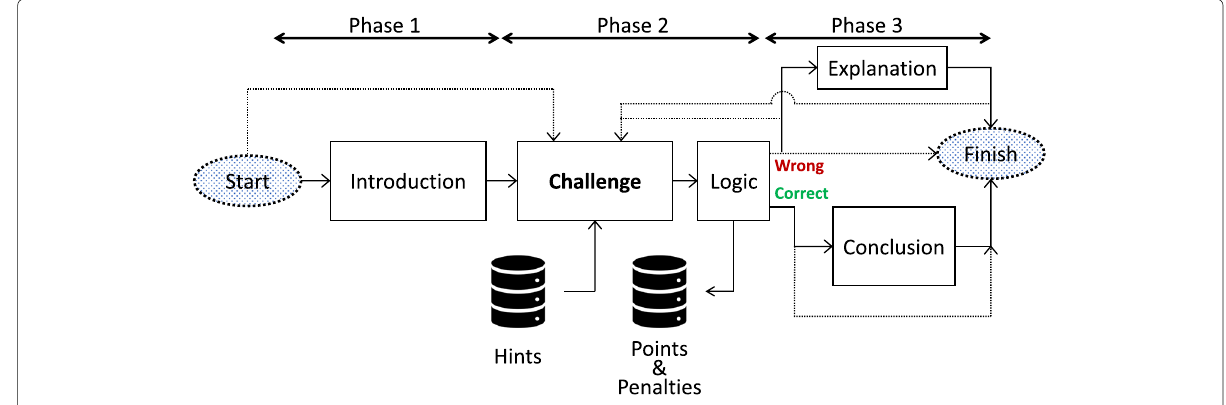
Fig. 4 Structure of a CyberSecurity